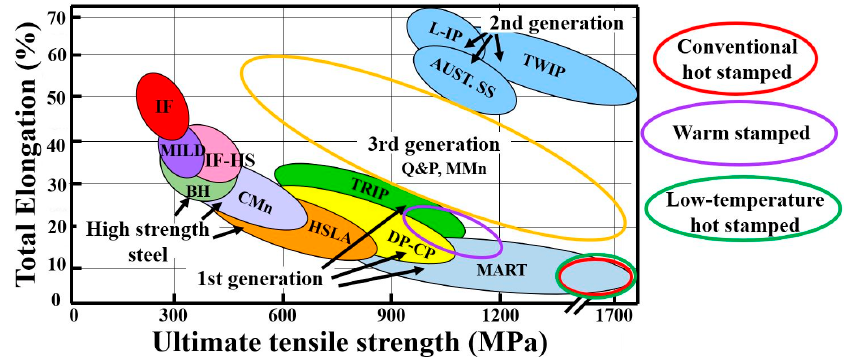
Figure 8. Comparison between mechanical properties of various types of industrially manufactured steel grades and of parts produced by various hot stamping processes. Q&P: quenching and partitioning; TRIP: transformation induced plasticity. IF: interstitial-free steels; MILD: mild steels; IF-HS: interstitial-free high-strength steels; BH: bake hardening steels; CMn: carbon-manganese steels; HSLA: high-strength low-alloy steels; TRIP: transformation induced plasticity steels; DP-CP: dual phase and complex phase steels; MART: martensitic steels; Q&P: quenching and partitioning steels; MMn: medium-Mn steels; AUST. SS: austenitic stainless steel; L-IP: lightweight steels with induced